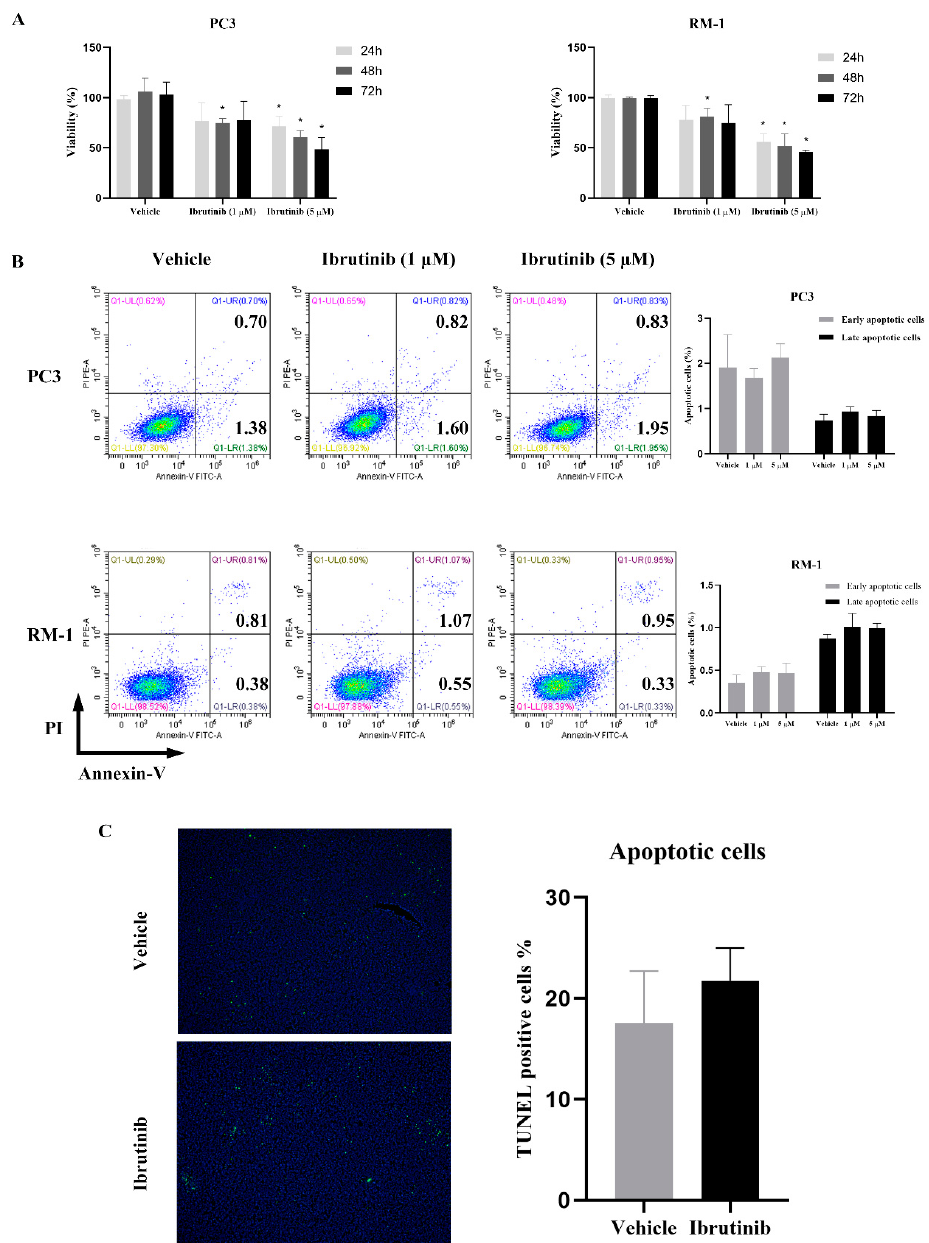
Figure 5. Ibrutinib inhibits PCa cell viability in vitro but does not induce comparable apoptosis at the indicated doses. ( A ) Human (PC-3) and mouse (RM-1) PCa cells were seeded in 96-well plates and treated with the specified concentrations (0, 1, and 5 µ M) of ibrutinib for 24, 48, and 72 h. A CCK8 assay was used to evaluate cell viability. ( B ) PC-3 and RM-1 cells were seeded in 24-well plates and treated with ibrutinib at 0, 1, and 5 µ M for 48 h. The cells were stained with PI (PE) and Annexin V (FITC), followed by flow cytometry detection. ( C ) Representative images of TUNEL staining and the percentage of TUNEL − positive cells (green) in mouse PCa tissues after treatment ( n = 4, original magni fi cation: 100×). A p value less than 0.05 was considered statistically signi fi cant. *, p < 0.05.